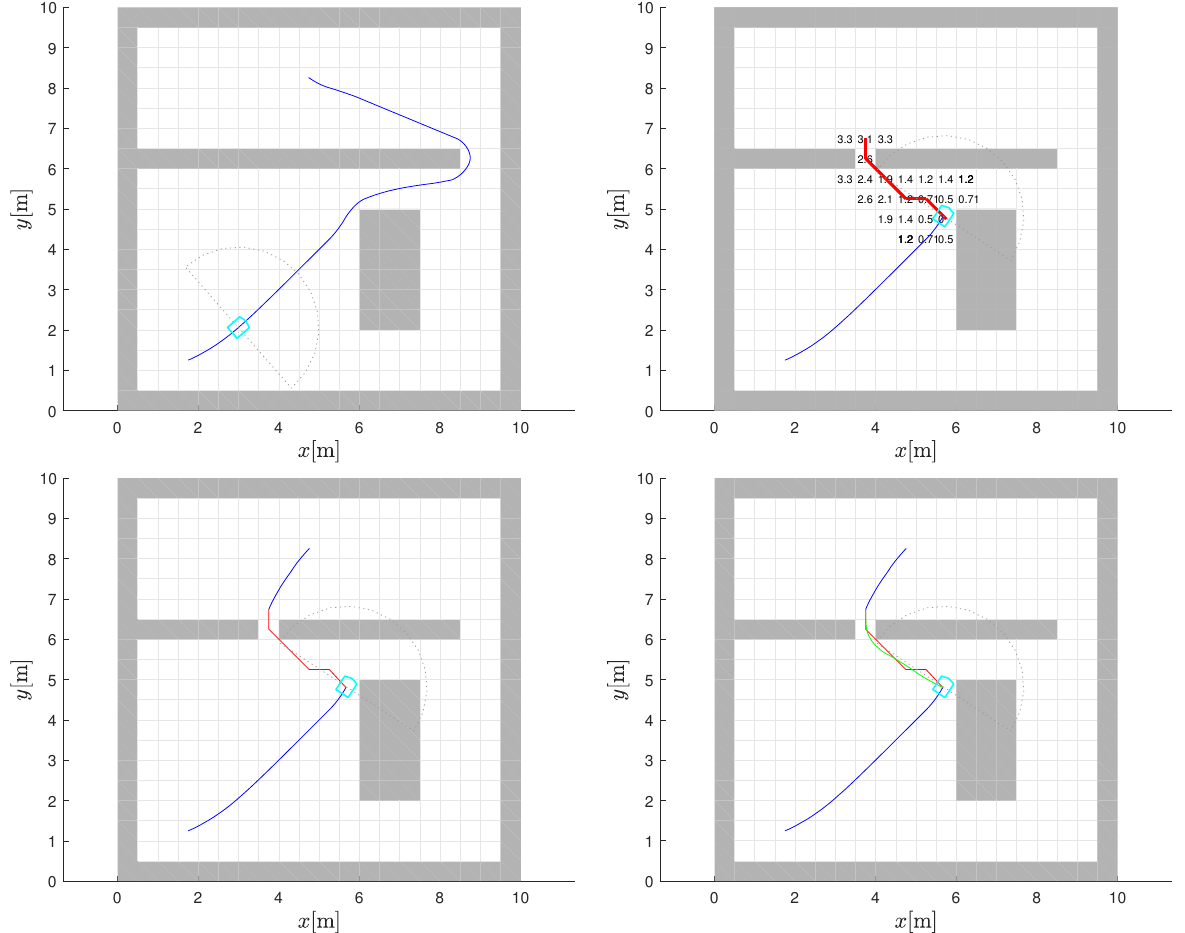
Figure 10. Path planning with obstacle cleared outside the robot sensor view. Initial path (blue line) planned based on knowledge of global static map is followed ( top-left ). Robot is informed of cleared obstacle cells (outside robot’s sensor view) and A* bypass path (red line) to an unblocked cell beyond cleared cell is computed ( top-right ). The composite alternative path made up of final gradient-descent path (blue line above the obstacle) using the original CtG ( bottom-left ) and smoothed bypass version (green line) ( bottom-right ) is shorter than the one in the ( top-left ) figure and robot switches to